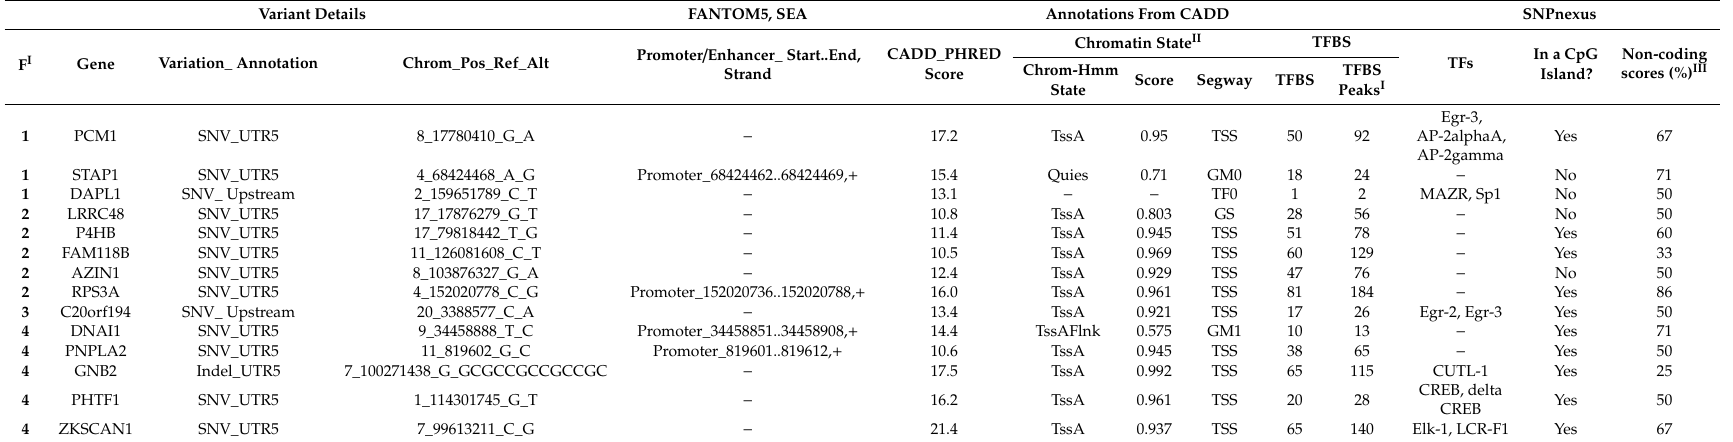
Table 2. Top upstream and 5 (cid:48) UTR variants prioritized according to the FCVPPv2. Variant annotation, chromosomal position, and regulatory consequences according to FANTOM5, SEA, CADD and SNPnexus are listed. The FANTOM5 database gives information on known promoters. CADD gives an overall deleteriousness score together with chromatin state information based on ChromHmm and Segway scores and information on transcription factor binding sites (TFBSs). Location of the variants within a specific TFBS and CpG island were obtained from SNPnexus. A cumulative non-coding score is shown as a percentage of positive scores from all scores listed in the footnote. Cut-o ff s for these scores are also indicated in the